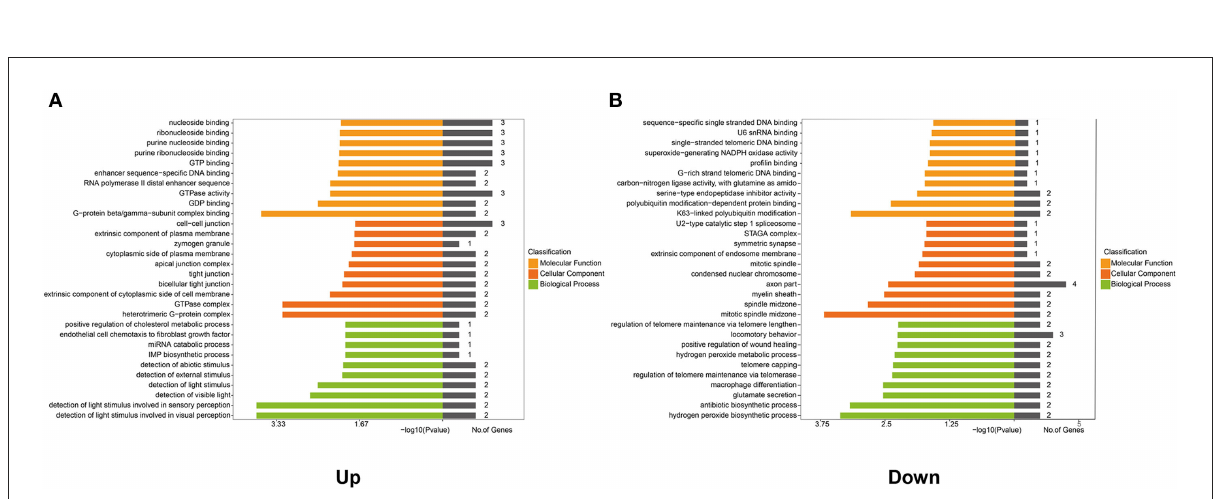
FIGURE5 Gene Ontology (GO) analysis of genes in the co-expression network. GO analysis shows: (A) The top 10 enriched terms associated with the molecular function (MF), cellular component (CC), and biological process (BP) of genes in the upregulated co-expression network. (B) The top 10 enriched terms associated with MF, CC, and BP of genes in the downregulated co-expression network.